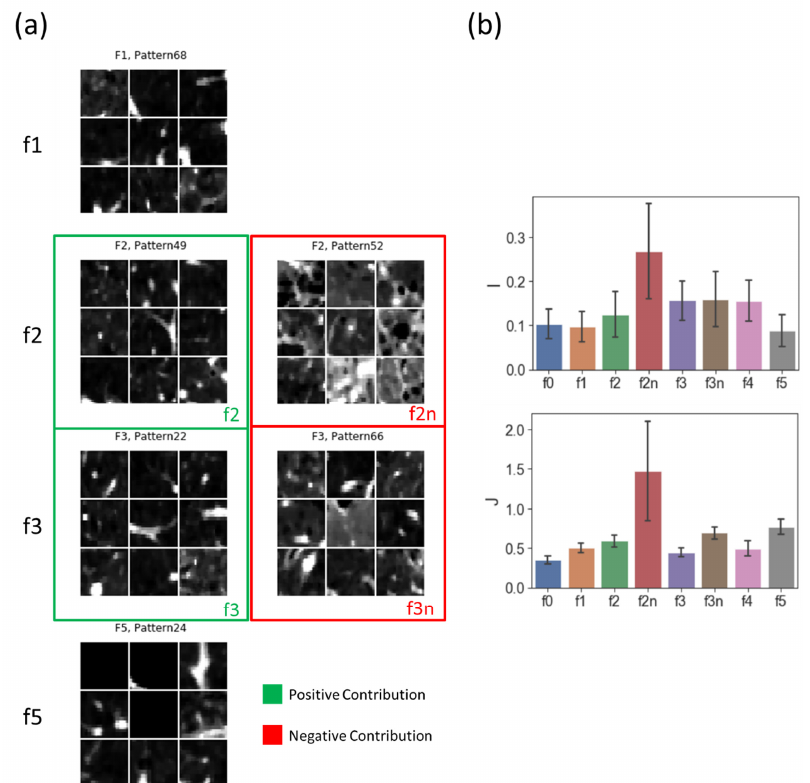
Figure 6. ( a ) Samples of the pattern clusters that showed a high contribution to the factors of F1, F2, F3, and F5. These four factors can differentiate C0 from C5. F2 and F3 are bi-polar factors; thus, there are pattern clusters with either positive (f2 and f3 in green boxes) or negative (f2n and f3n in red boxes) contributions to them. ( b ) Averaged CT attenuation (I) and averaged Jacobian (J) of the pat- tern clusters which had showed a contribution to each factor. Correlations between the factors and common clinical and imaging-based variables were also calculated in order to better interpret the results (Figure 7). F1 and F2 were neg- atively correlated with Tissue%_Total and Tissue% for all the lobes. F3 was negatively correlated with LAA RV %_Total and LAA RV % for all the lobes, while F5 was positively cor- related with LAA RV %_Total and LAA RV % for all the lobes. F1, F2, and F3 were negatively correlated with RV/TLC. On the contrary, F5 was positively correlated with RV/TLC. Moreover, F1 was positively correlated with LAA TLC %_Total, LAA TLC %_LUL, and LAA TLC %_RML, while F5 was positively correlated with fSAD%_Total and fSAD% for all the lobes. However, F1, F2, F3, and F5 were not strongly correlated with the clinical vari- ables of BMI, weight, height, age, FEV 1 %, and FVC%.